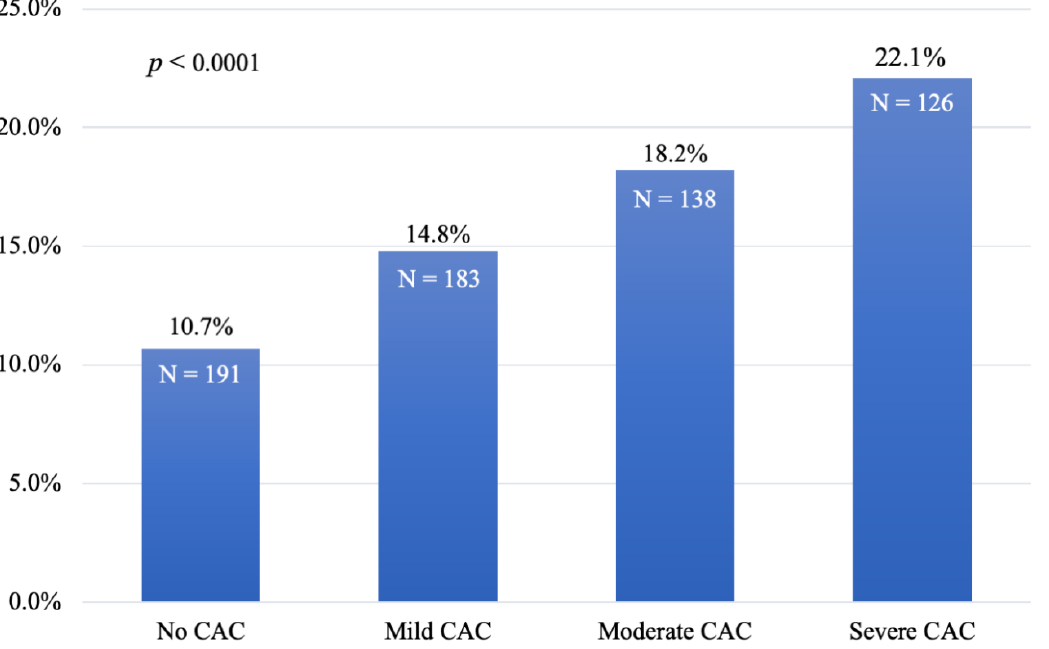
Figure 2. Association of the CAC grade with the 10-year risk of ASCVD. The average 10-year ASCVD risk score of patients in the total study population was based on their respective CAC classification of no CAC, mild CAC, moderate CAC, or severe CAC. p < 0.0001. CAC—coronary artery calcification, ASCVD—atherosclerotic cardiovascular disease.